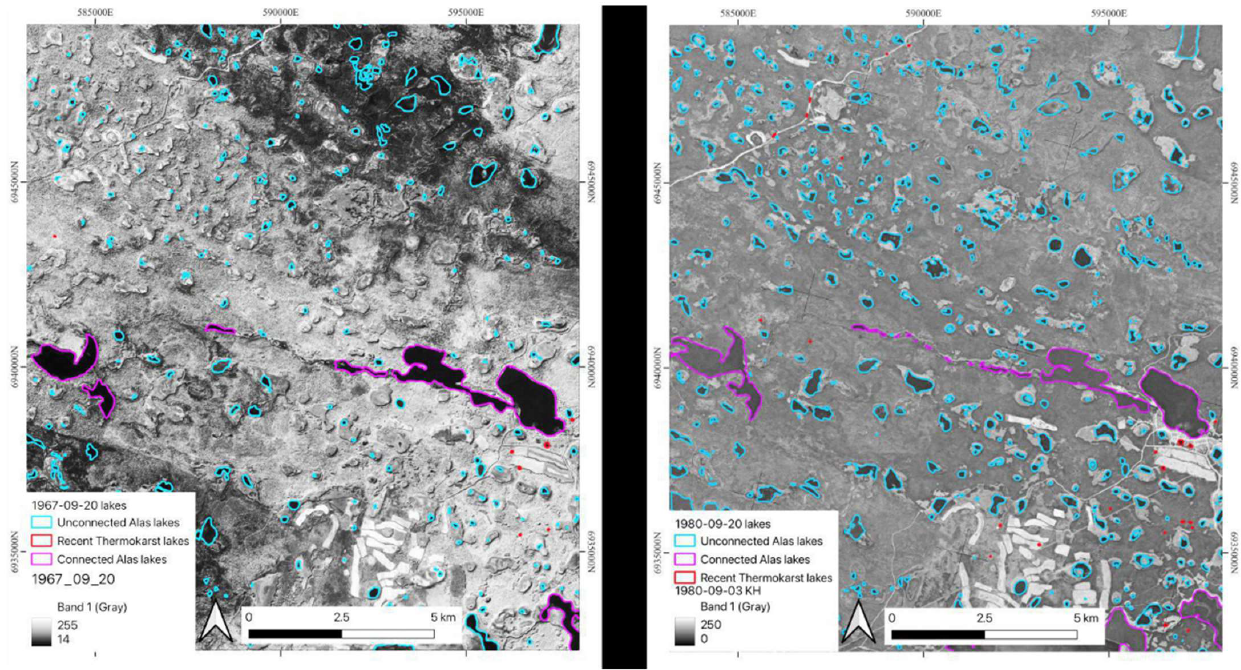
Figure 16. 1967 (September 20) scene ( left ) and 2010 (September 23) scene ( right ). In the 1967 scene, there are many UCA basins which have no lake or only a small residual lake. In the 2010 scene, most of these lake basins are occupied by more substantial UCA lakes.